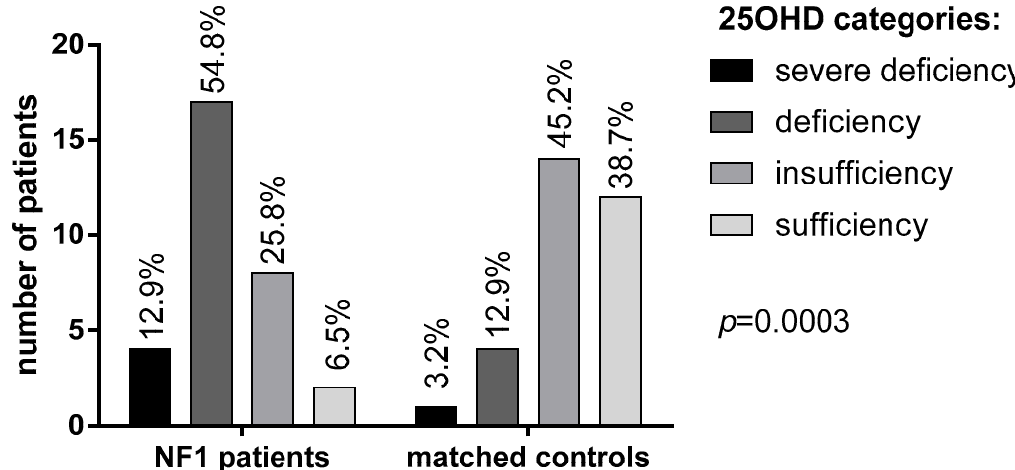
Figure 1. 25OHD levels in patients with NF1 and controls according to the Endocrine Society Guidelines [23] .